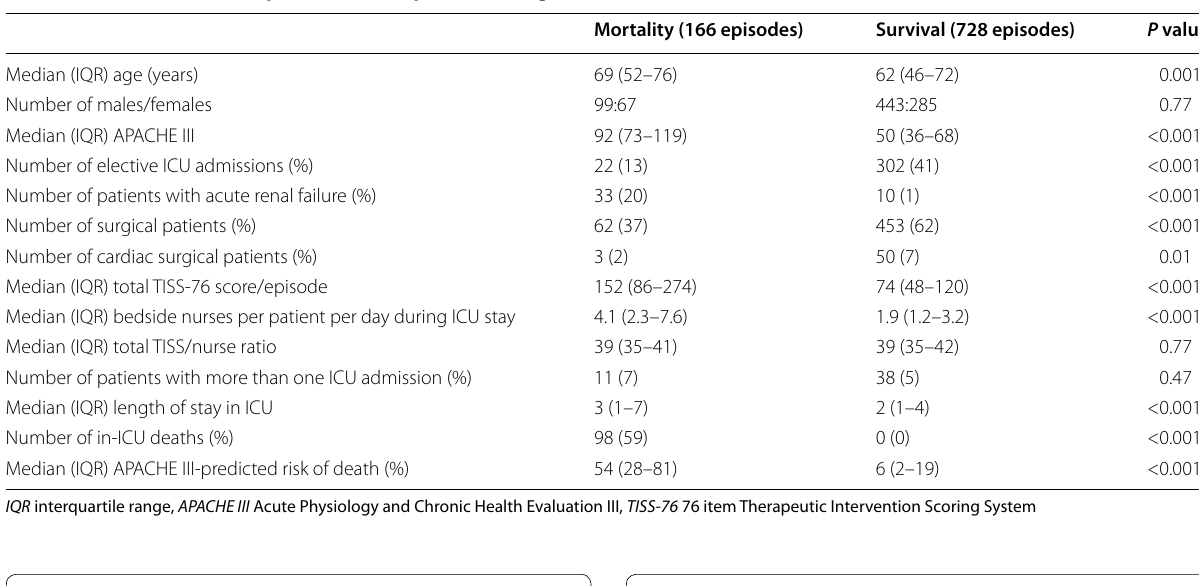
Table 2 Characteristics of patients at hospital discharge